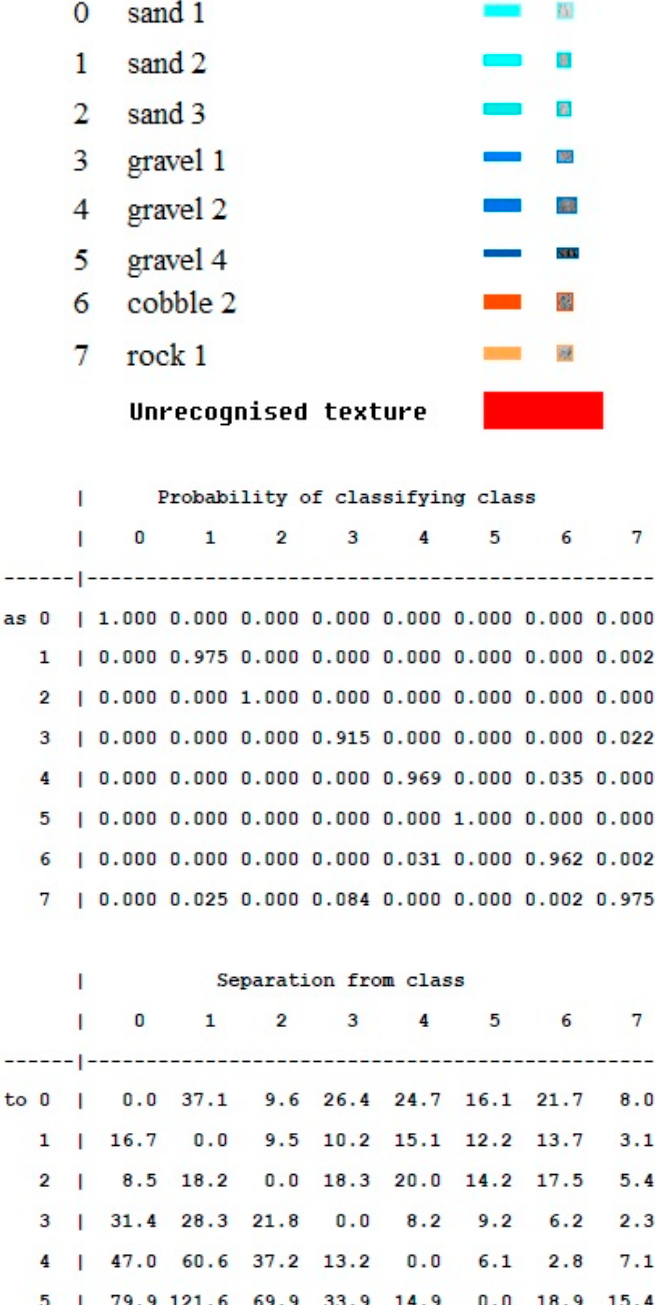
Table 3. Top: Seabed image textures for a subset of the areas of the seabed selected for the mid-frequency greyscale sonar image during a user-supervised image texture characterisation process, subsequently used to generate the classified image (Figure 7). Bottom: A matrix of the probabilities of classifying one class as another; and a matrix of class separations (in standard deviations) computed for the image texture characteristics extracted from the mid-frequency greyscale backscatter image.